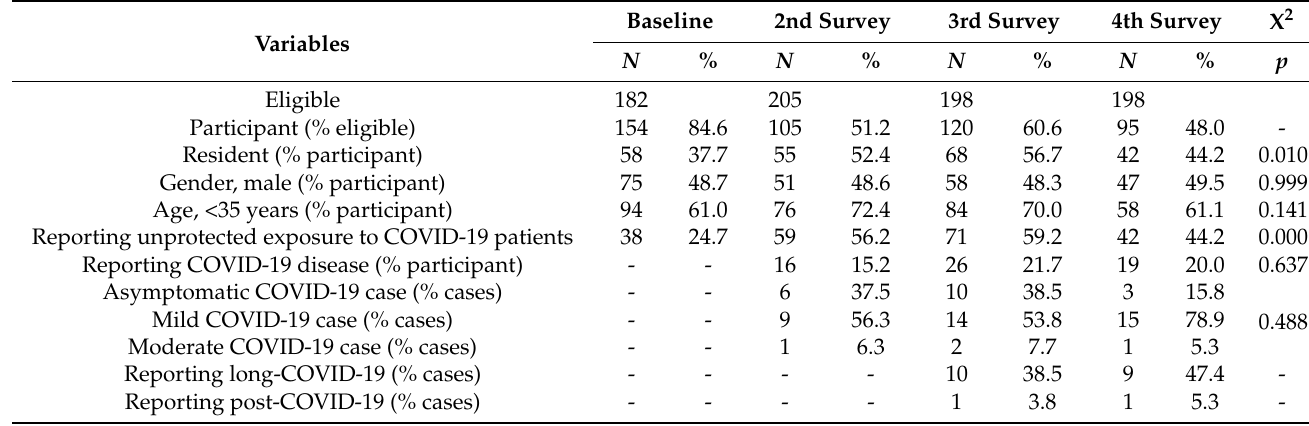
Table 1. Characteristics of the population in the different phases of the prospective study.